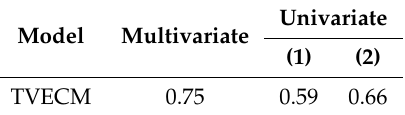
Table 7. p -values of Doornick–Hansen normality test for